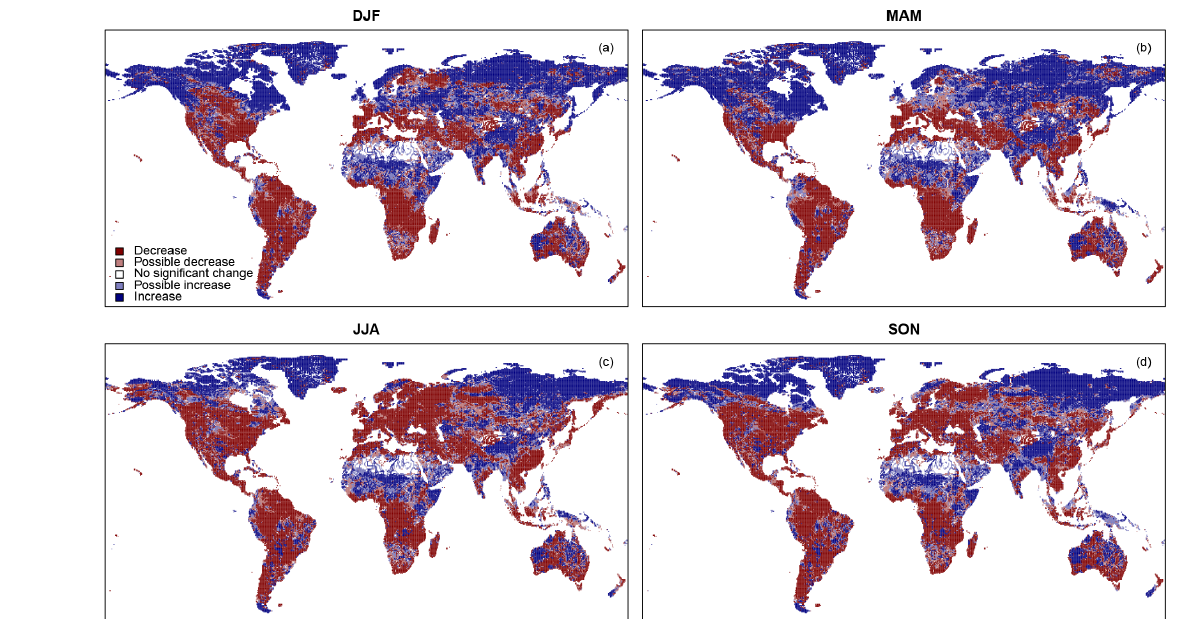
Figure 2. Average trends in the transient Q 90 threshold in the four seasons derived from simulation with PCR-GLOBWB. Trends are aggregated over 3-month periods for an ensemble of 20 members consisting of four RCPs and five GCMs. An increase or decrease is significant when over 16 ensemble members show similar trends. When over 13 ensemble members agree on the directionality of the change, the trend is deemed possible.